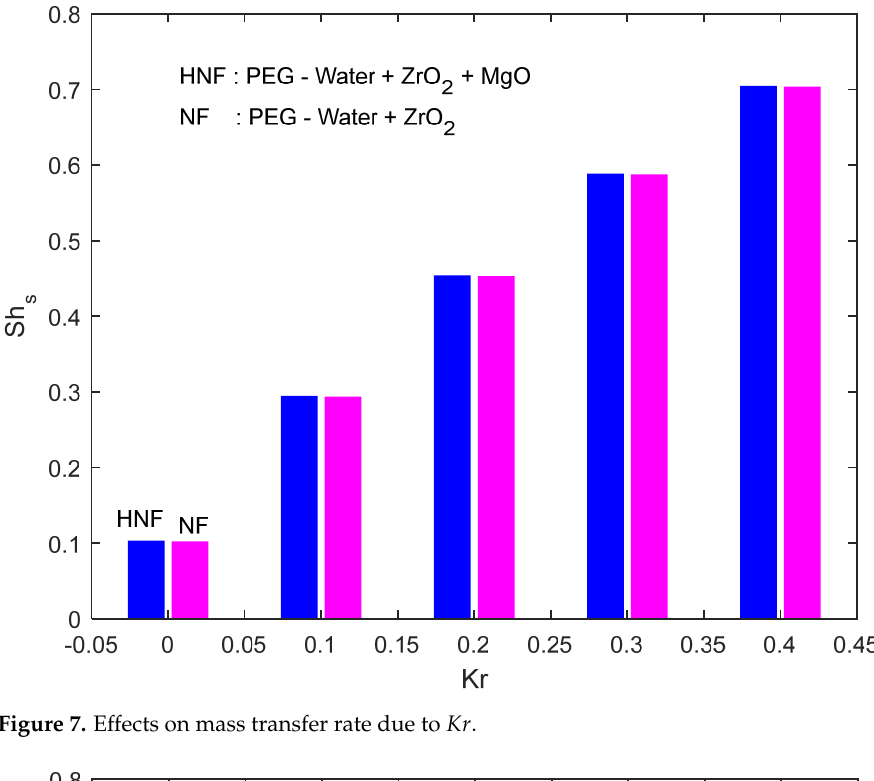
Figure 7. Effects on mass transfer rate due to Kr .